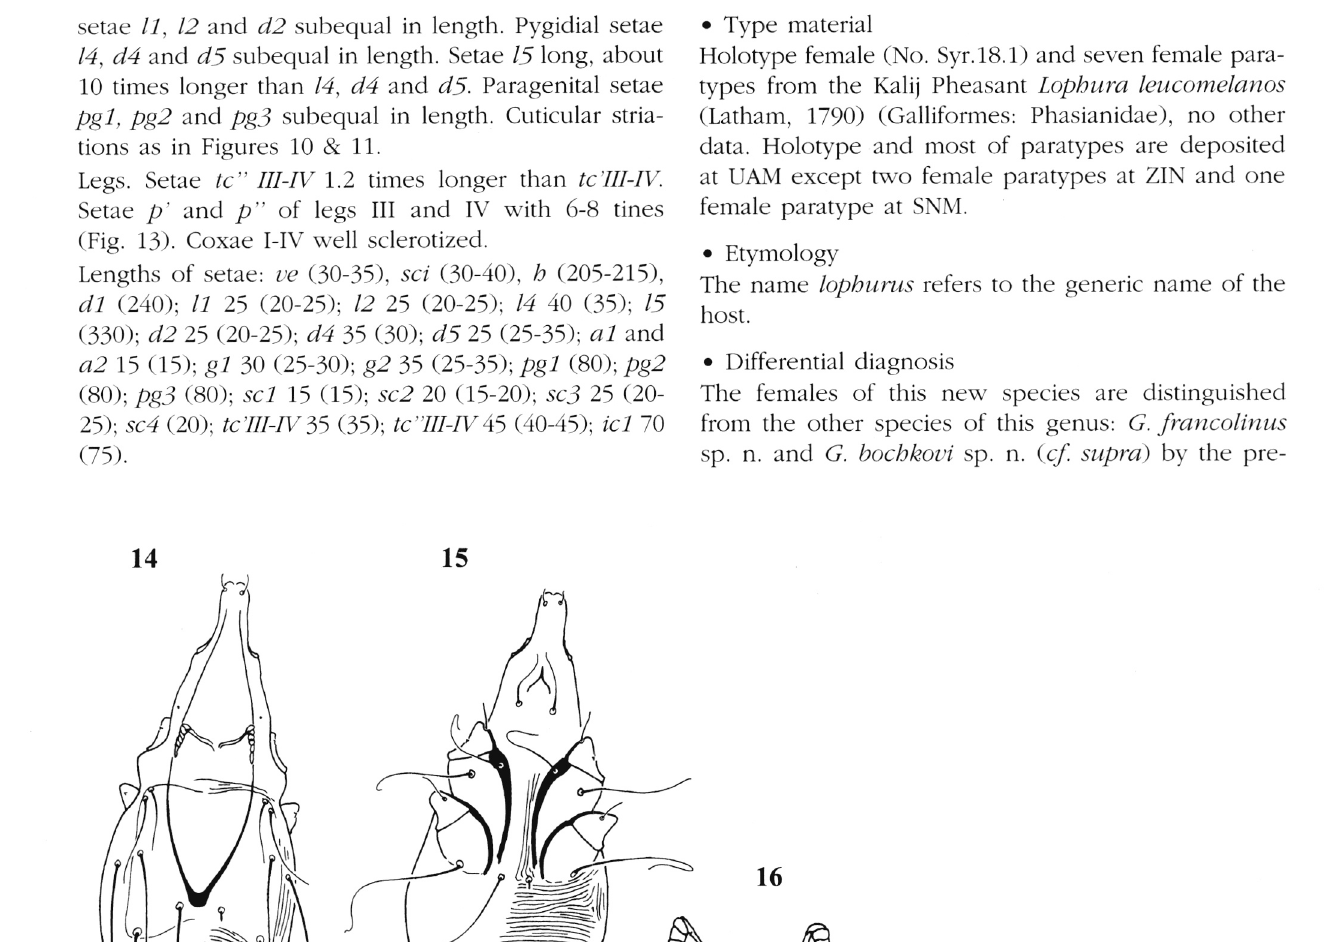
Figs 14-18. - M ironovia rouloul sp. n. Female. Female, 14. Dorsal view. 15. Ventral